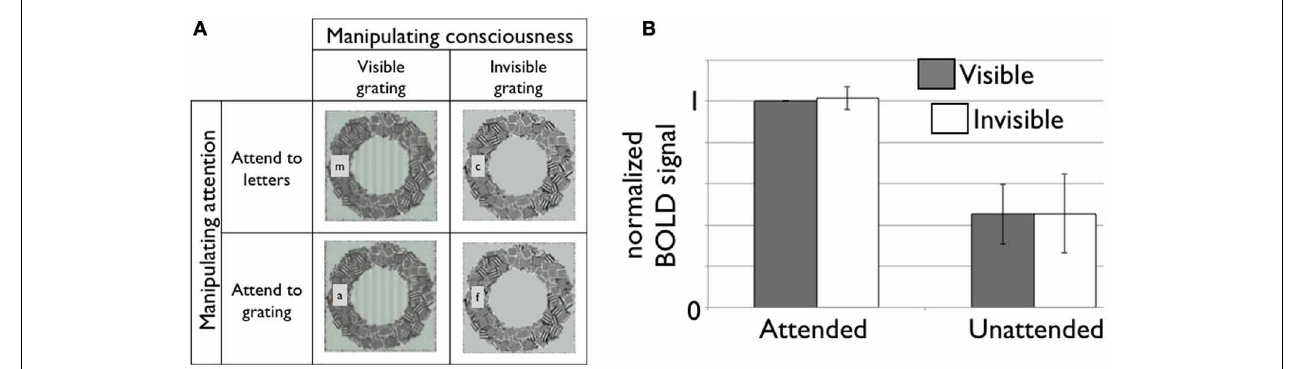
FIGURE 4 | (A) A 2-by-2 factorial design for independent manipulation of top-down attention and conscious visibility of the stimulus (Watanabe et al., 2011). Subjects are asked to carry out one of two attention tasks while viewing either a visible or invisible target stimulus. At the same time, dependent variables, such as hemodynamic responses in the brain, are measured. Here, we illustrate roughly what participants perceived in each condition (not the physical stimulus) in the study by Watanabe and colleagues.